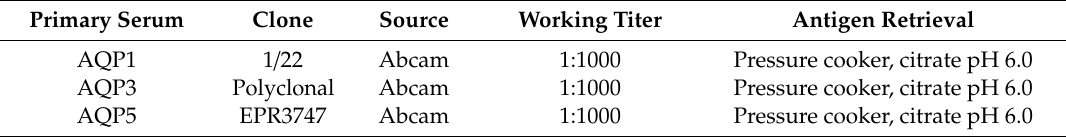
Table 3. Primary serum, clones, source, working titers, and antigen retrieval. Primary Serum Clone